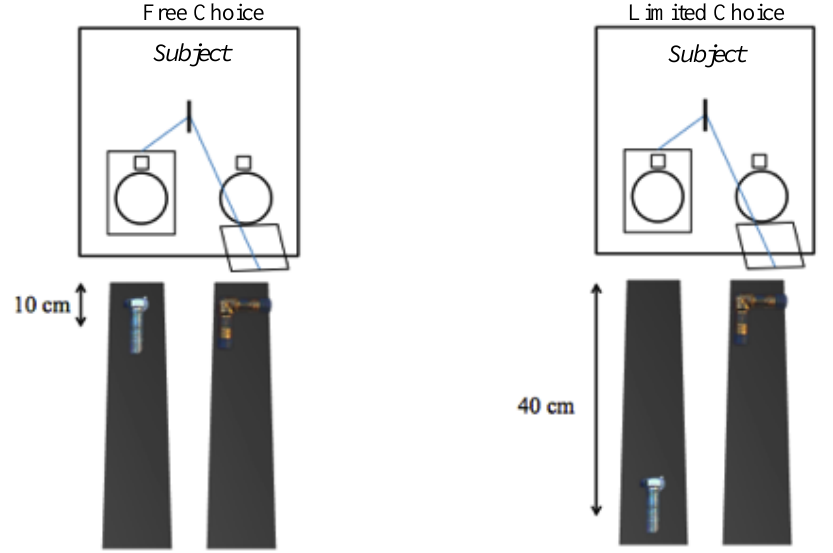
Figure 3 . Experimenter’s view of the choice presentation. Choices were made using a choice apparatus (designed by Salwiczek et al., 2012), which consisted of two doors fastened by Velcro, attached to each other by a string that worked in a drawbridge-like fashion; that is, one door pulled closed when the other was pushed open. In the Free Choice condition (left), the two objects were located within reach of the model, while in the Limited Choice condition (right), only one object was within reach, so the subject was forced to choose this object. Neither trapdoor was ever blocked regardless of